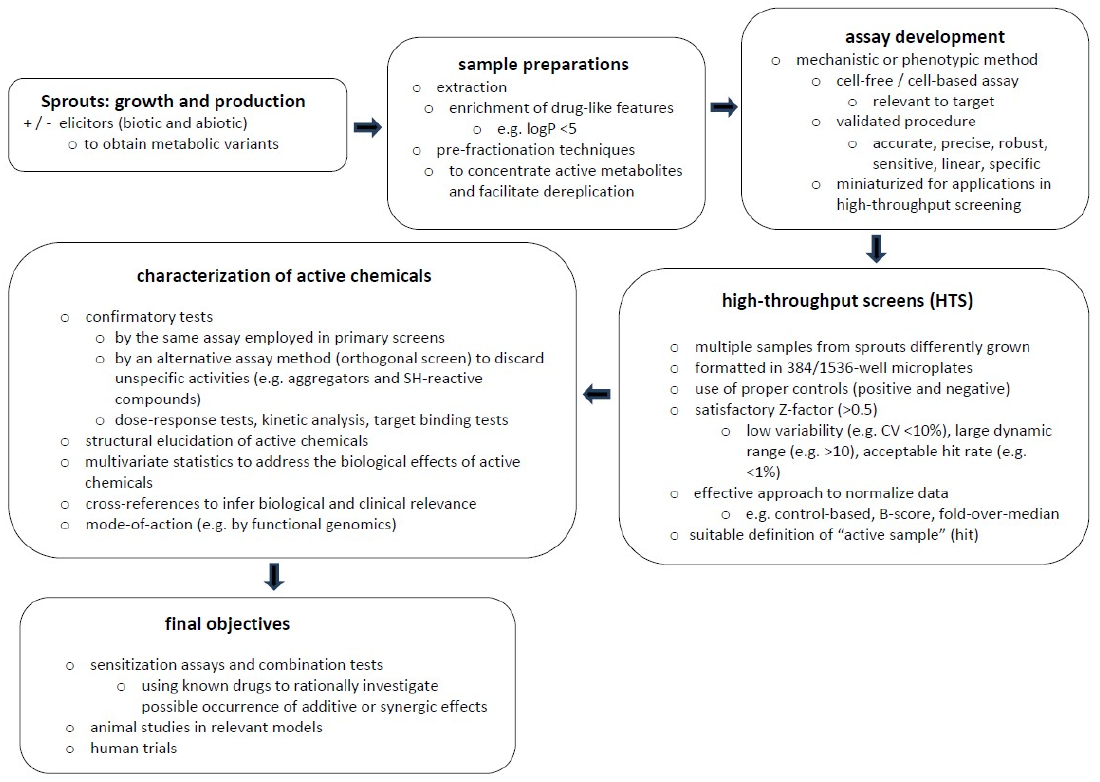
Figure1. Schematicexampleofanexperimentalworkflowaimedtoselectandidentifypharmacologically Figure 1. Schematic example of an experimental workflow aimed to select and identify active chemicals from pharmacologically active chemicals from sprouts.